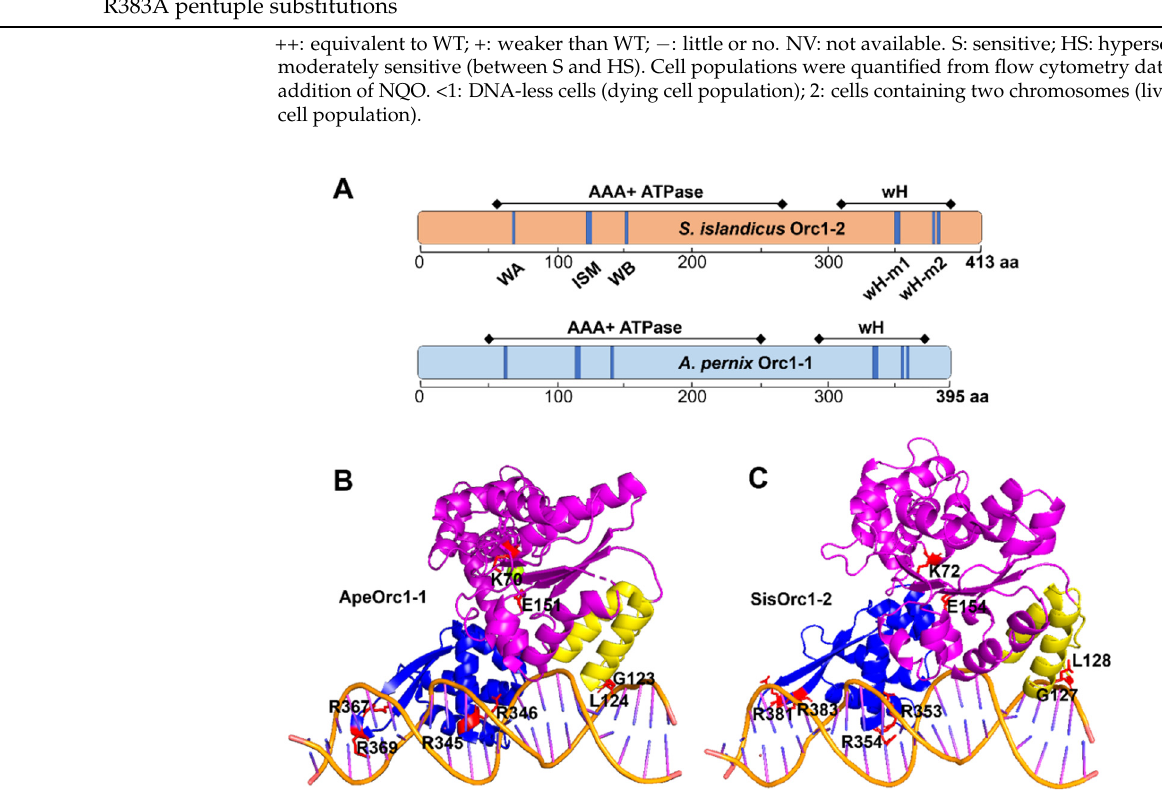
Figure 1. Structural modeling reveals DNA binding motifs in the wH domain of Orc1-2. ( A ) Schematic of domain organization of the S. islandicus Orc1-2 and A. pernix Orc1-1. Positions of conserved motifs are highlighted in blue. ( B ) Crystal structure determined for the A. pernix ORC1 protein in complex with DNA (PDB: 2V1U). The AAA+ ATPase domain is shown in purple and ISM is colored dark yellow, whereas the wH domain is in blue. Residues chosen for substitution are shown as red sticks. ( C ) Simulated structure of Orc1-2 ADP on DNA generated with PyMOL using the structure in ( B ) as the template. Conserved motifs are highlighted in red in each functional domain, which were subjected to mutagenesis, as specified in Table 1. Table 1. Genetic analysis of structural domains of the S. islandicus orc1-2 gene.